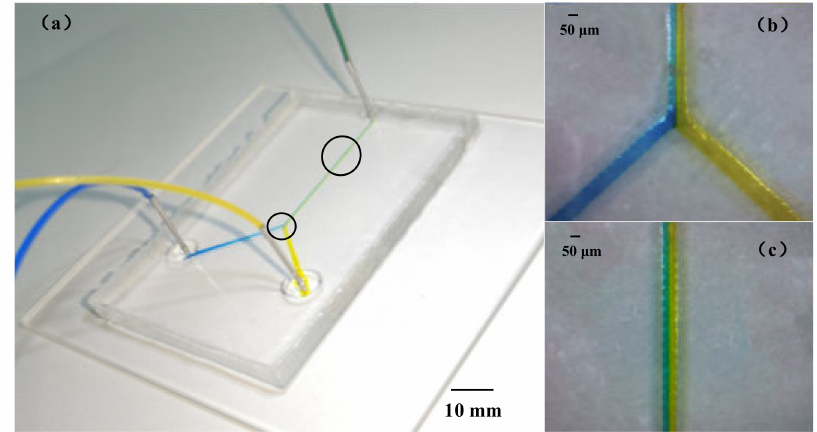
Figure12. TheY-shapedmicrochannel: ( a )mixinginthemicrochannelatafeedingspeedof10 µ L min − 1 ; ( b ) the mixed fluid at the junction; and ( c ) the mixed fluid near the